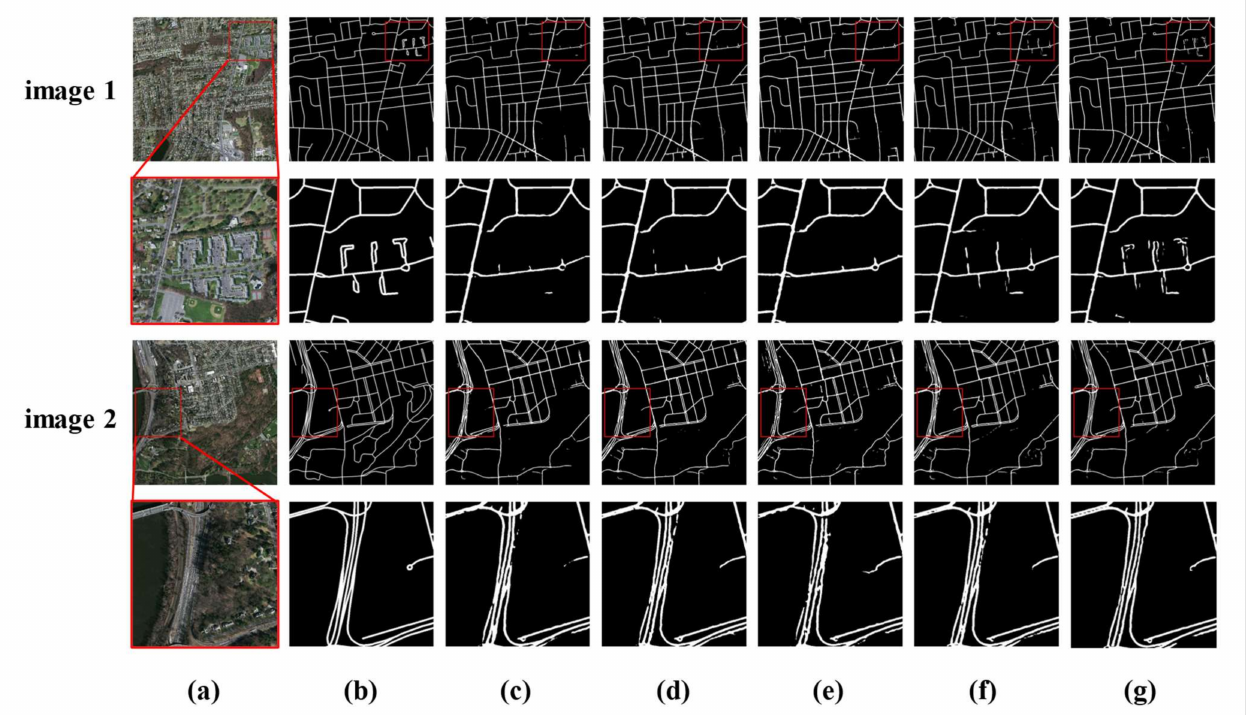
Figure 7. Visualization result of road segmentation from different methods. ( a ) The test image. ( b ) The ground truth. ( c ) Results with DeepLabV3+. ( d ) Results with D-LinkNet. ( e ) Results with D-ResUnet. ( f ) Results with DCS-TransUperNet. ( g ) Results with